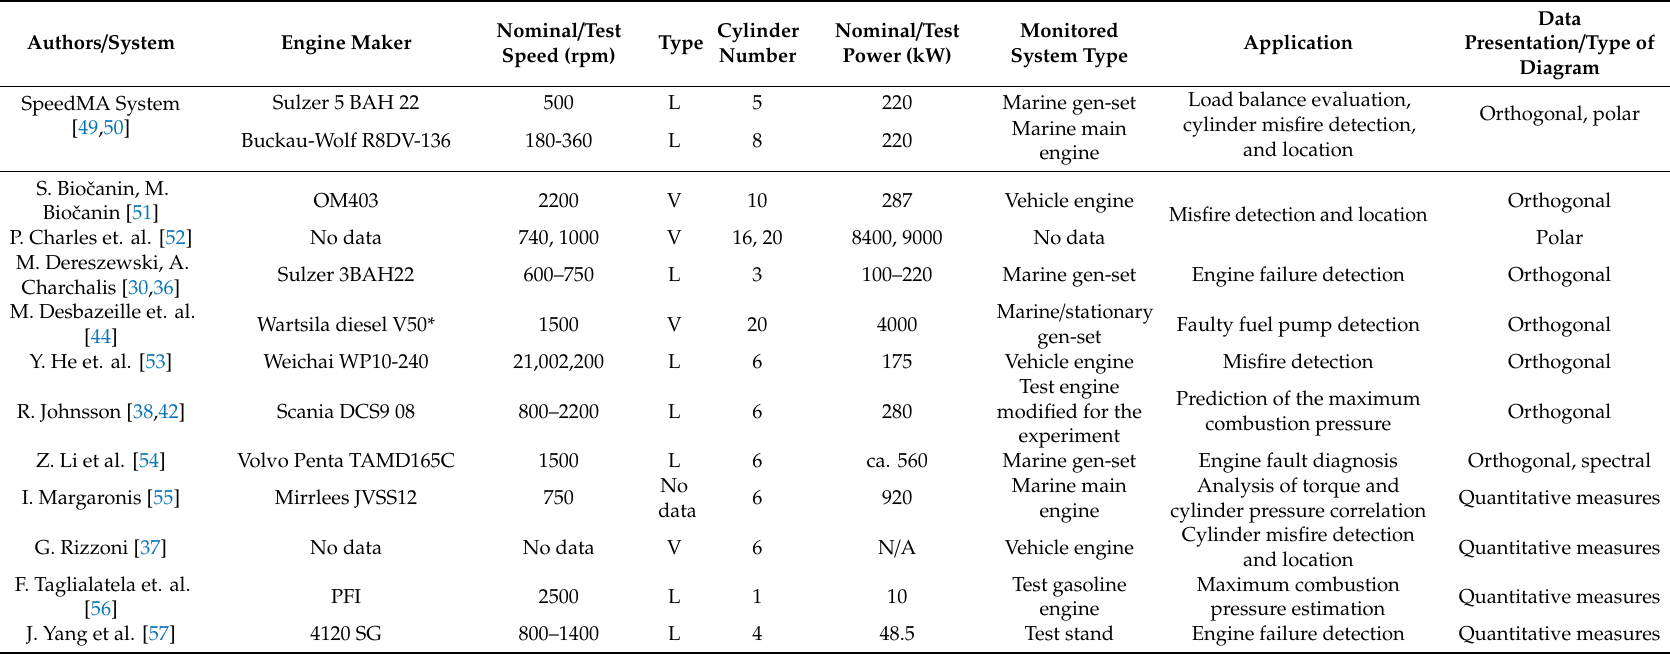
Table 1. Comparison between the proposed instantaneous speed monitoring system and the works of other